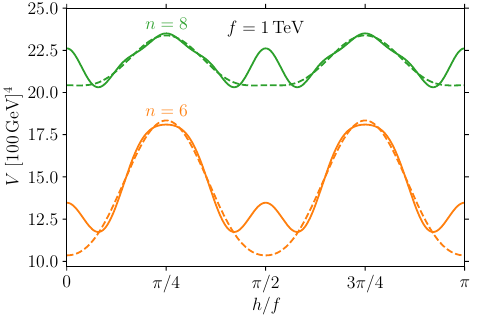
for n = 6 , 8 and f = 1 TeV. Dashed G